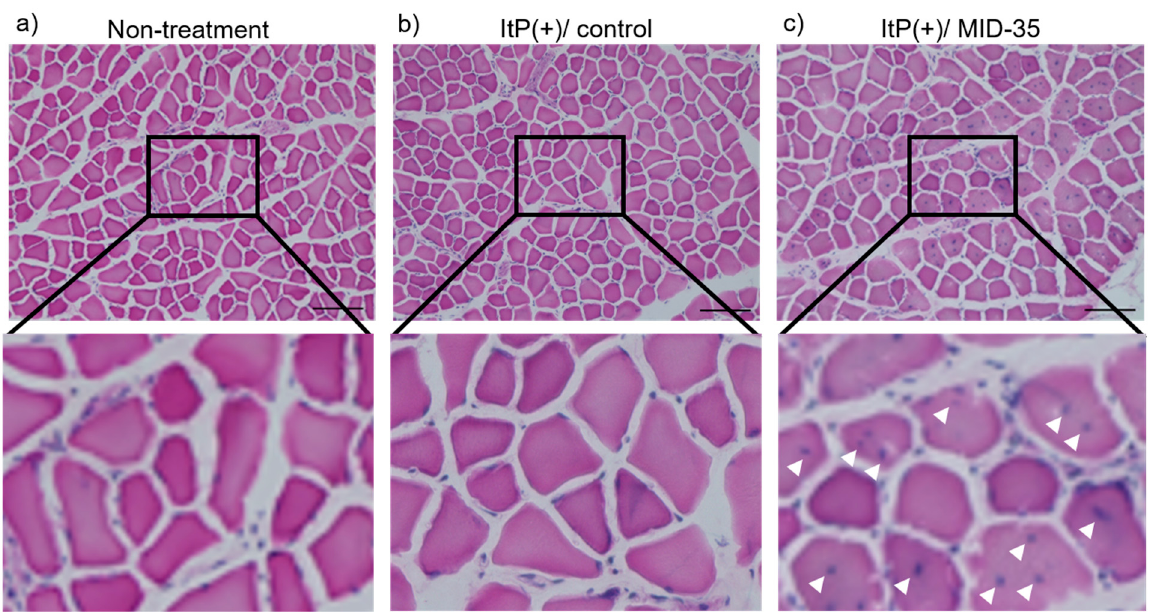
Figure 3. Effect of iontophoretic intramuscular delivery of MID-35 on muscle fiber morphology: Muscle tissues were collected from ( a ) non-treated mice, ( b ) control mice treated with ItP and PBS (ItP(+)/control) and ( c ) mice treated with ItP/MID-35 (ItP(+)/MID-35). The muscle sections were stained with HE and observed by light microscopy. The upper three images were collected at 100× magnification, and the lower three images are magnified view. White arrows indicate the central nuclei. The length of the black bar is 100.